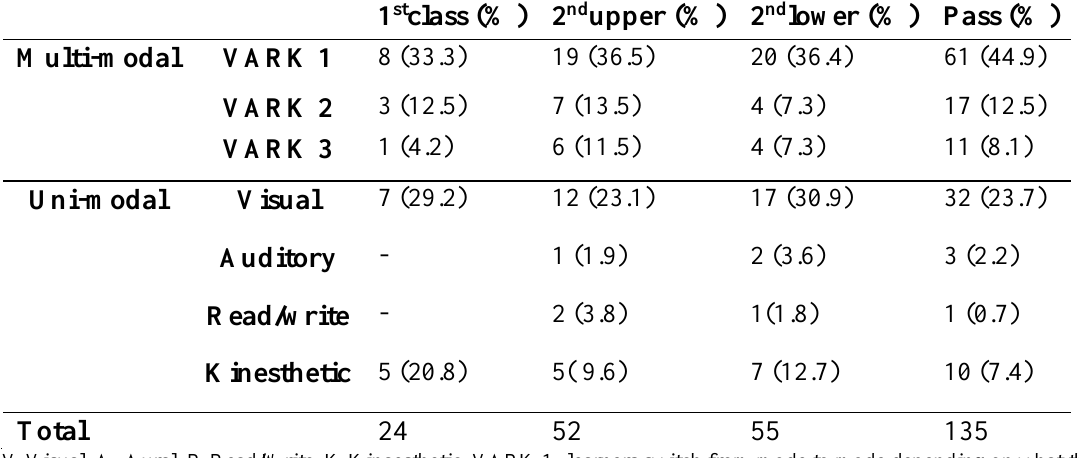
Table 4. Comparison of learning preferences according to academic performance